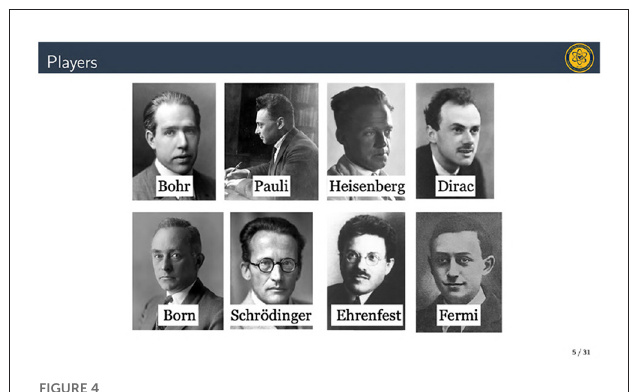
FIGURE4 Important players in twentieth-century physics. Lecture